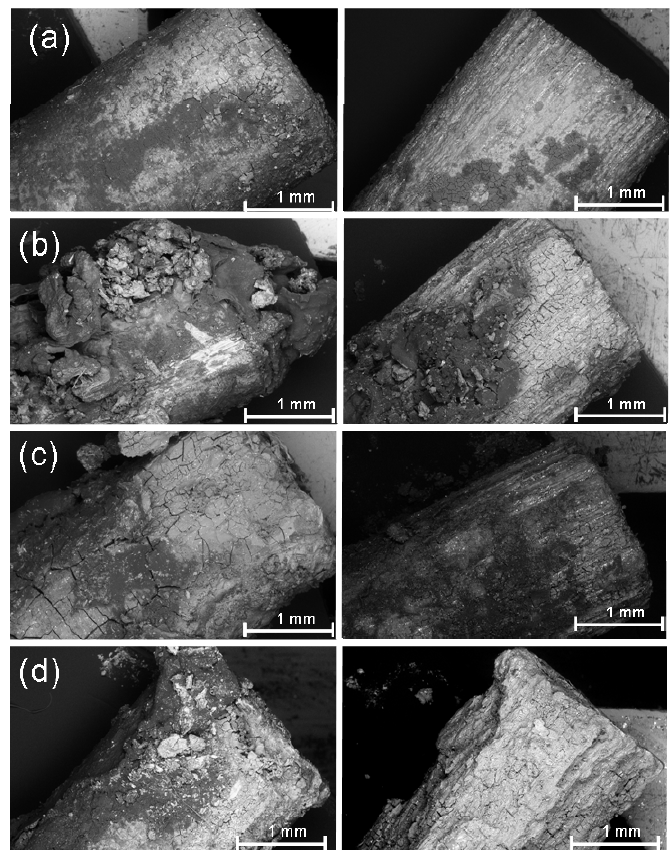
Figure 7. SEM images of the pin ends: ( a ) 4 weeks; ( b ) 8 weeks; ( c ) 13 weeks;